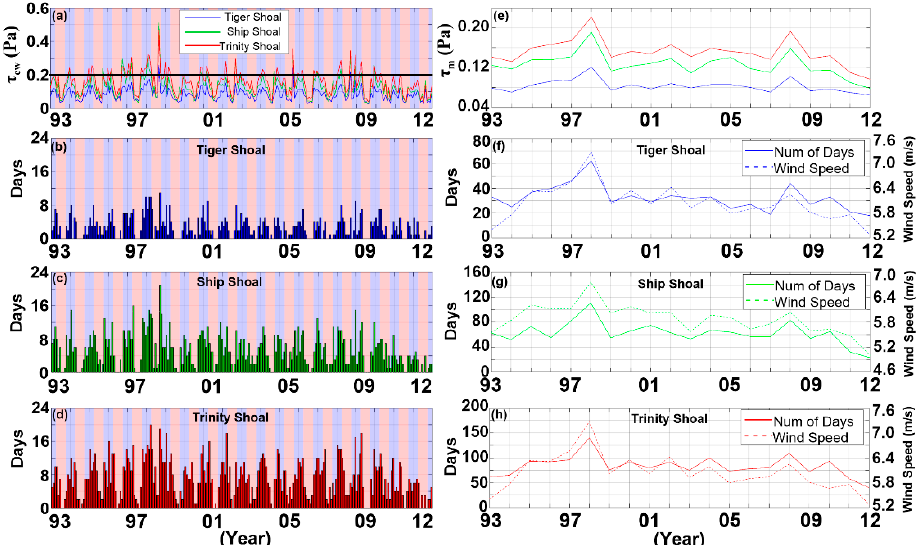
Figure 19. Monthly spatial-averaged (diagonal cross region in Figure 1) bottom shear stress over Tiger Shoal (blue), Ship Shoal (green), and Trinity Shoal (red), and the black solid line shows the highest critical shear stress ( τ c = 0.2 Pa) of fluvial sediments ( a ). Histograms indicate the number of days in one month with strong resuspension (daily spatial averaged bottom shear stress τ cw > 0.2 Pa) over Tiger Shoal ( b ), Ship Shoal ( c ), and Trinity Shoal ( d ). The background color shows cold season (October–March; blue) and warm season (April–September; red). ( e ) shows spatial-averaged, annual mean bottom shear stress ( τ m ) over each shoal (same legend as panel a). ( f )–( h ) show the number of days with excessive bottom shear stress ( τ cw > 0.2 Pa) in one year and annual mean wind speed over three shoals.